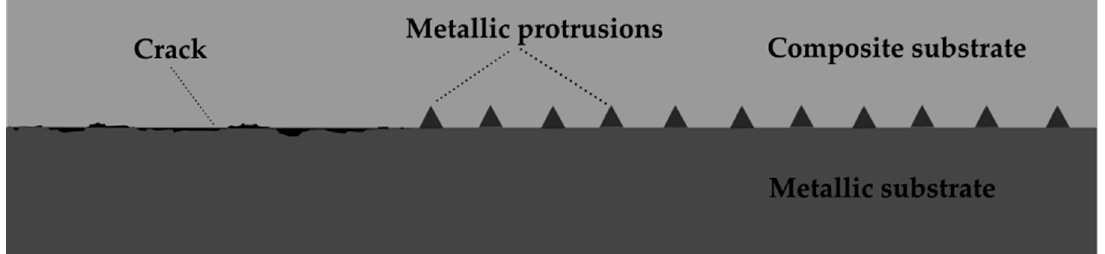
Figure 7. The concept of through-the-thickness metallic protrusions for hybrid metallic–composite joints.